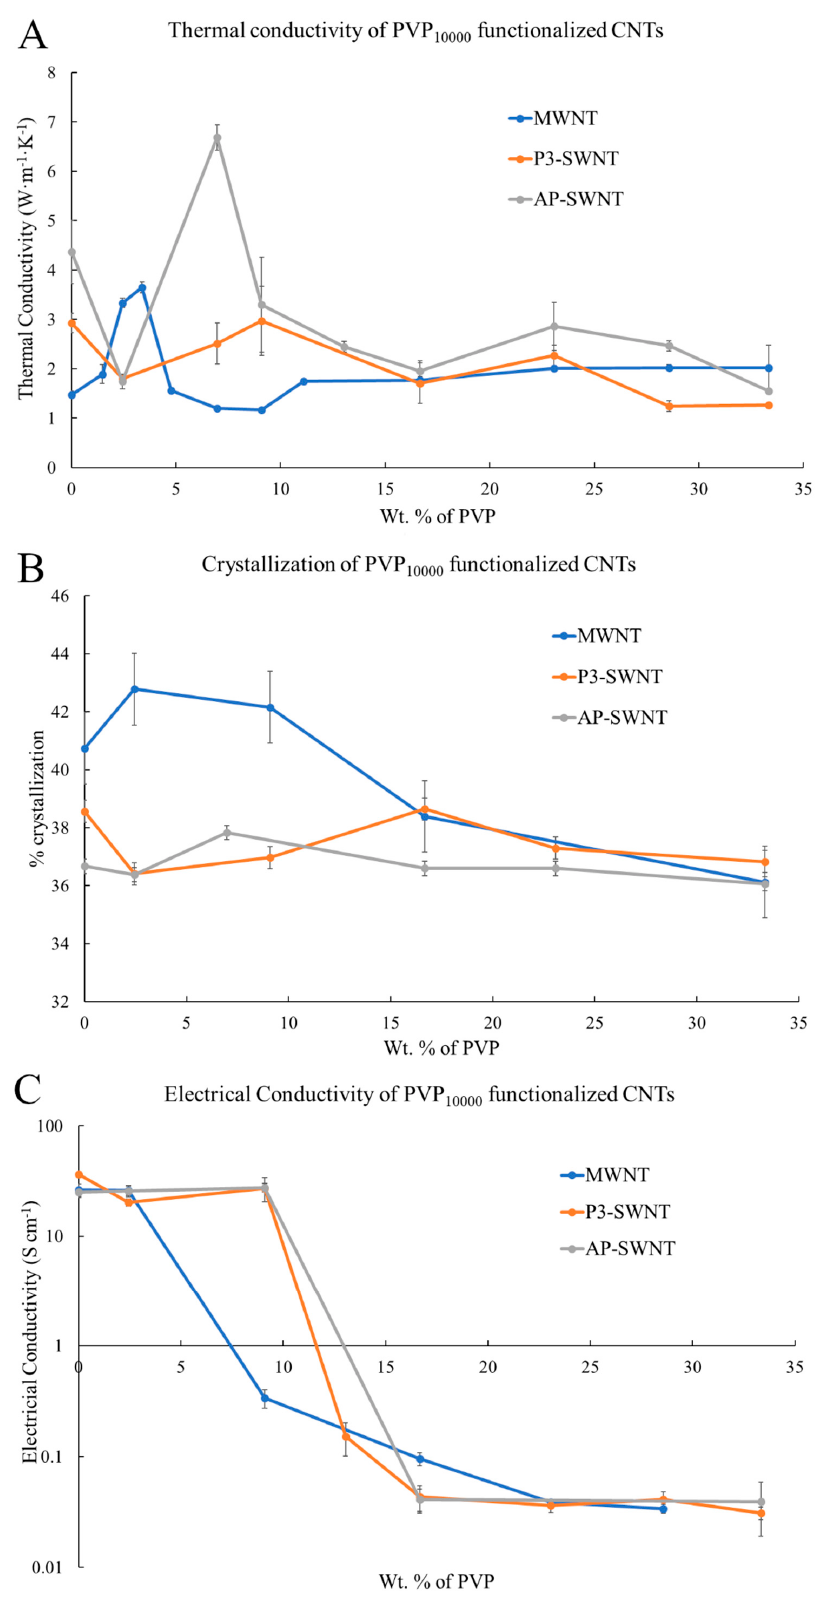
Figure 1. ( A ) Thermal conductivity of three different types of PVP 10000 functionalized CNT/PVDF composites; ( B ) Percent Crystallization; and ( C ) Electrical conductivity of PVP 10000 functionalized CNT/PVDF composites at different PVP